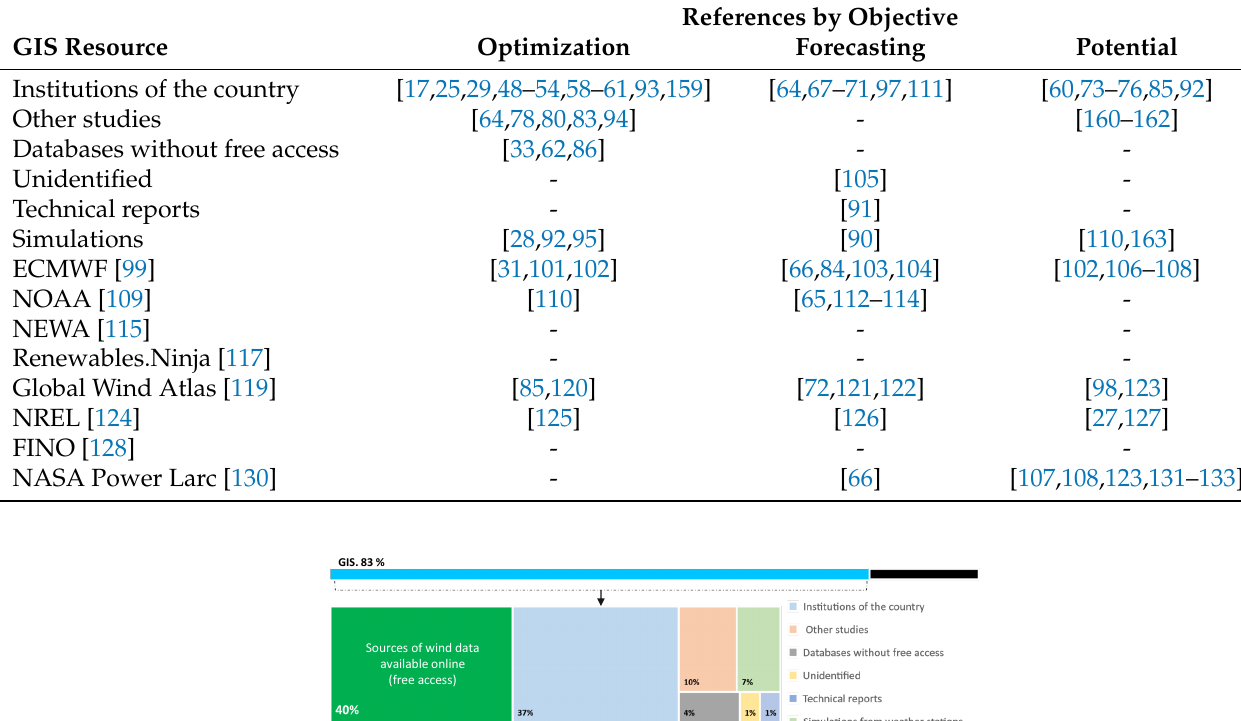
Table 5. Results of the identification by contributions with GIS tool integration.